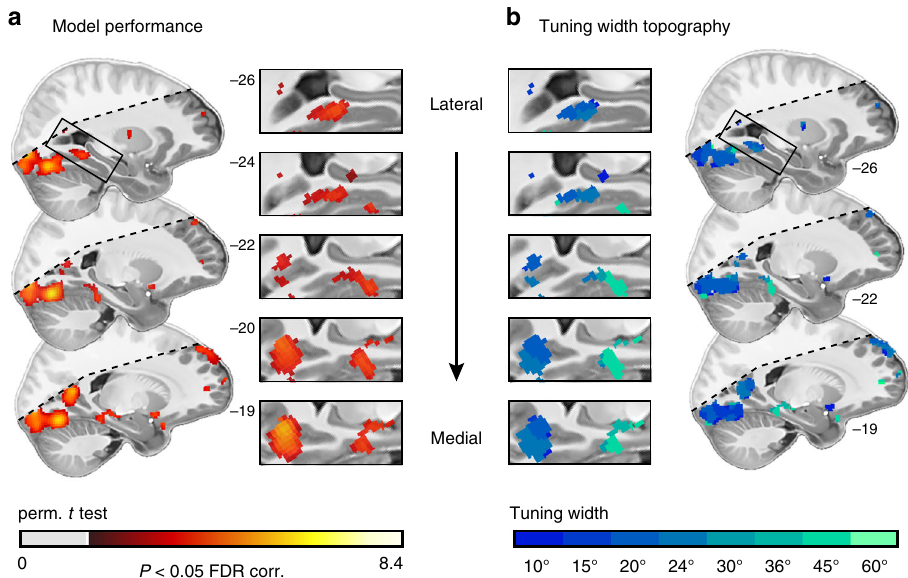
Fig. 3 Mapping directional tuning across the human cortex ( n = 20). a Tuning map: directionally tuned voxels were determined by testing model performance against zero on group level using a permutation-based one-sample t test with k = 10,000 shuf fl es. We plot pseudo-T map thresholded at P < 0.05, FDR-corrected for all basis sets at T1 resolution overlaid on the group-average T1 scan. Approximate MNI coordinates were added. Inserts zoom in on the parahippocampal cortex and the medial parietal cortex. Multiple regions in the occipital lobe, the medial parietal and temporal lobes, and the parahippocampal gyrus were directionally tuned. b Tuning width: for each directionally tuned voxel, we color-coded the median tuning width (full-width-at- half-maximum of the directional kernels in the optimal basis set) that led to the highest pseudo- T value (depicted in a ). The tuning width follows a narrow- to-broad topology along the parahippocampal long-axis. Shaded regions fell outside the scanning fi eld of view in at least one participant. Source data are provided as a Source Data fi le.